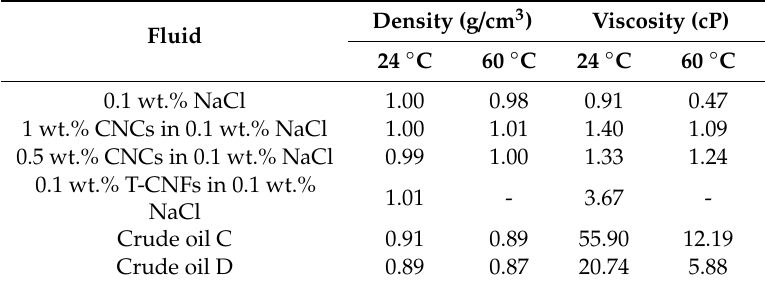
Table 2. Fluid properties.